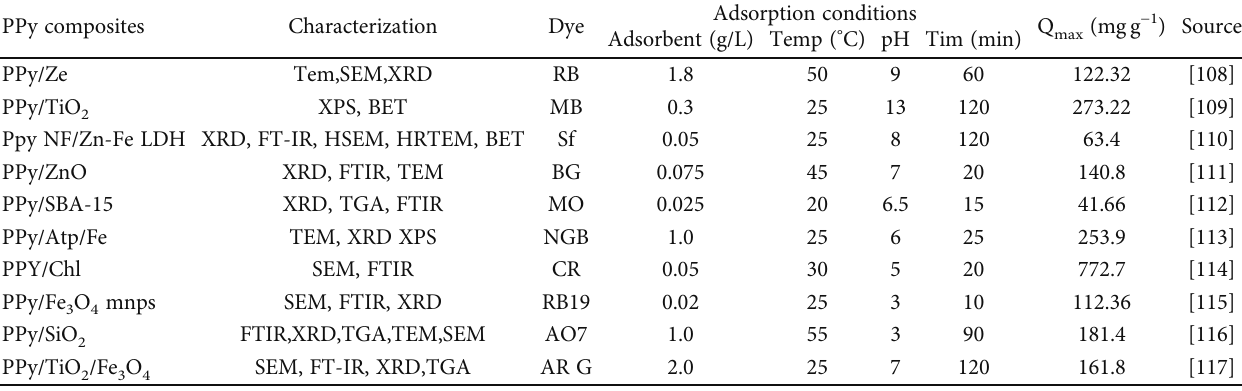
Table 5: PPy and its composites used for degradation of dyes.